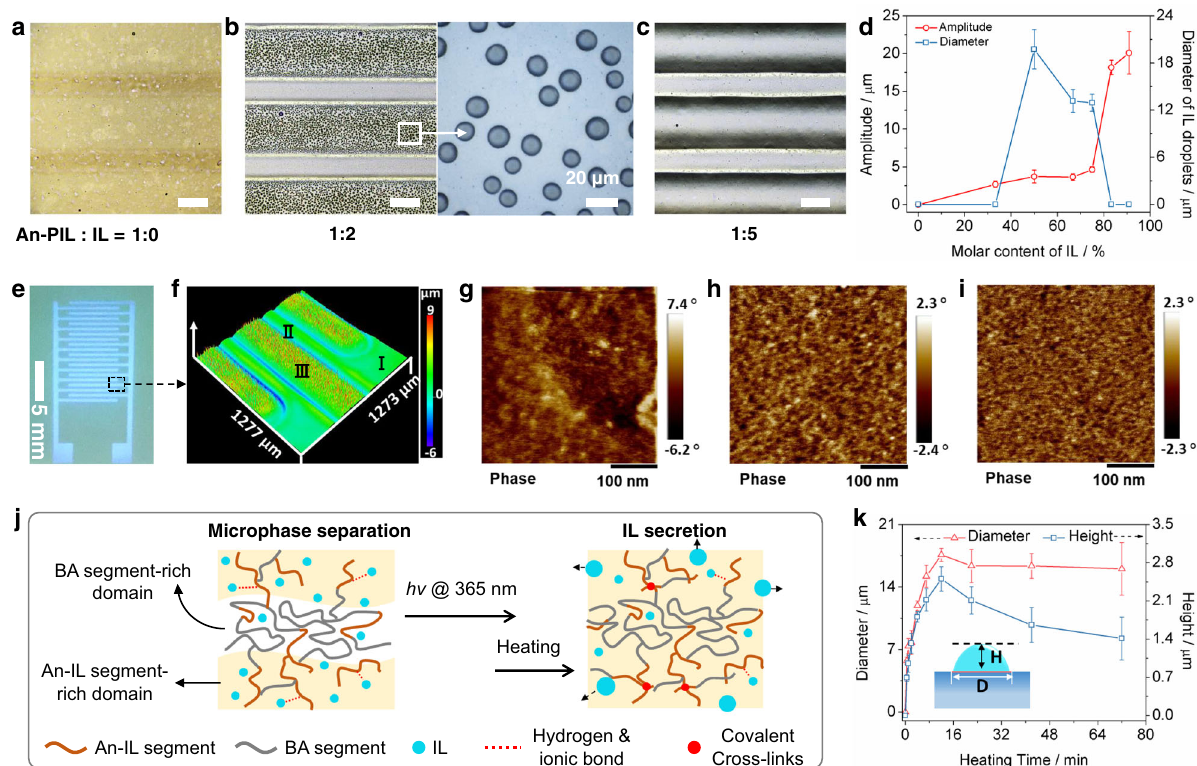
Fig. 2 | Photodimerization and in-situ phase separation of the iontronic host. a – c Microscopy images of iontronic hosts after photodimerization crosslinking andheating;scalebar:200 μ m. d Amplitudevariationsoftheprimarypatternsand diameter changes of the IL droplets versus the molar content of IL. Error bars represent the standard deviations of three independent data. e Fluorescence image and f the corresponding LSCM image of the IL droplets @primary patterns; I, II, and III represent the unexposed region, transition region, and the exposed